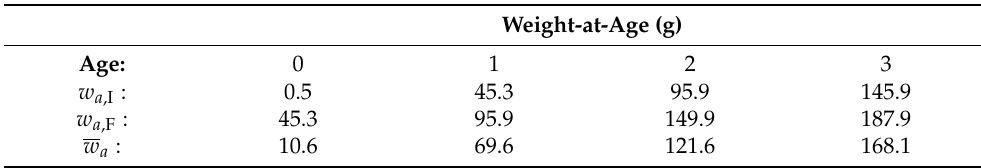
Table 1. Weight-at-age of Gulf menhaden at the beginning ( w a,I ) and end ( w a,F ) of a year, and the average over a year ( w a ), from Table 3.10 in